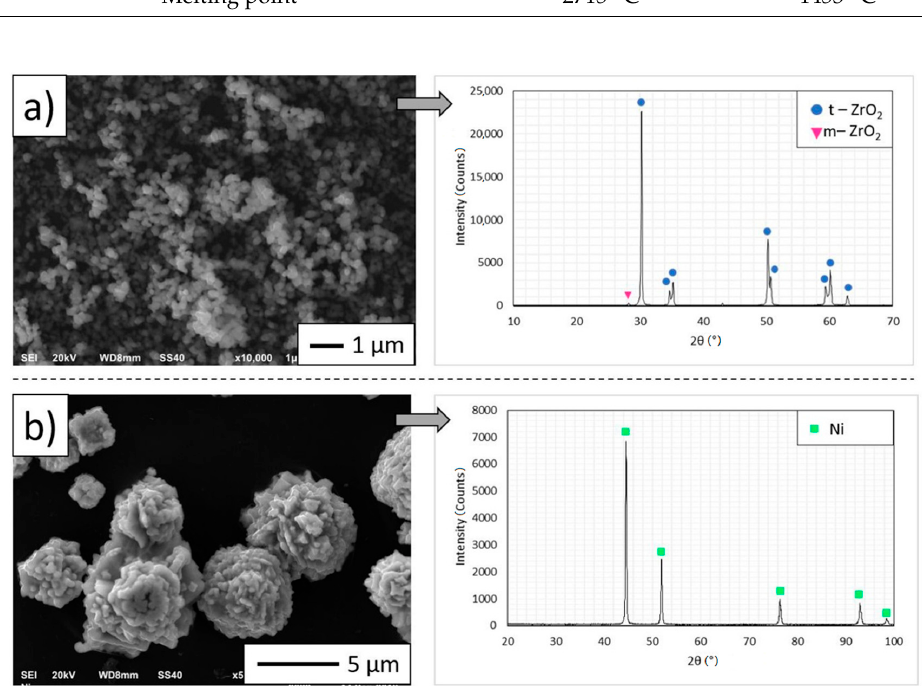
Figure 1. Scanning electron micrograph and XRD pattern of raw materials: ( a ) ZrO 2 , ( b ) Ni.